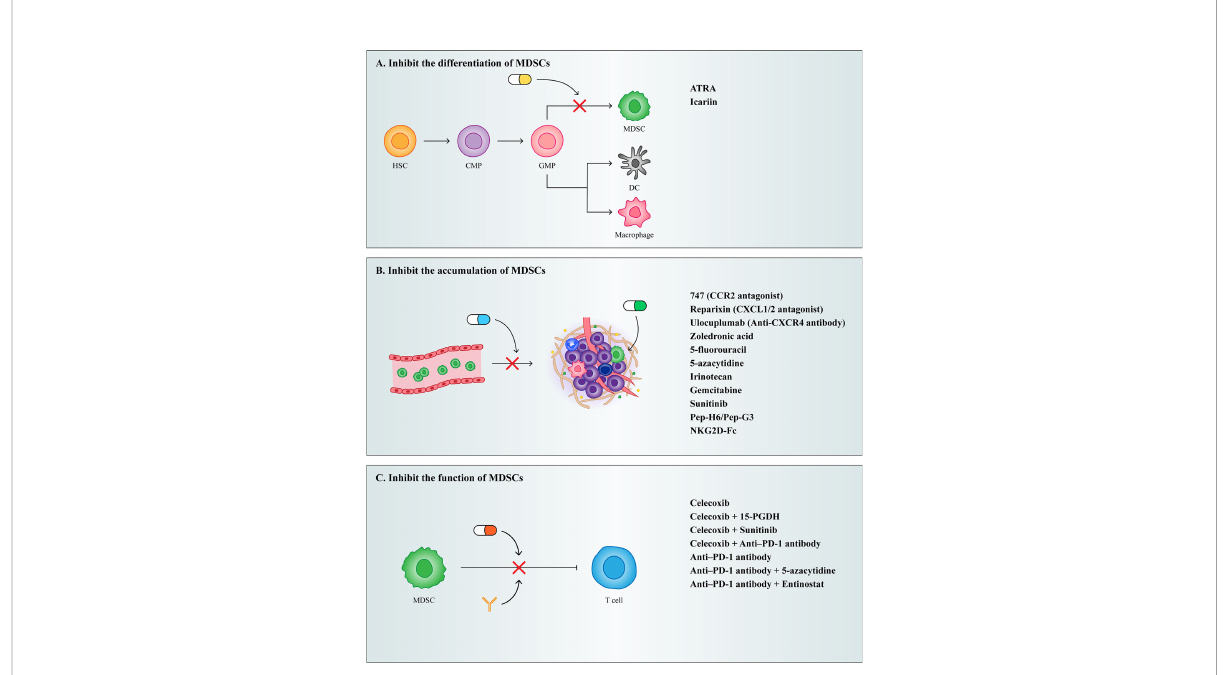
FIGURE 4 Treatment strategies for MDSCs. (A) Inhibit the differentiation of MDSCs. (B) Inhibit the accumulation of MDSCs. (C) Inhibit the function of